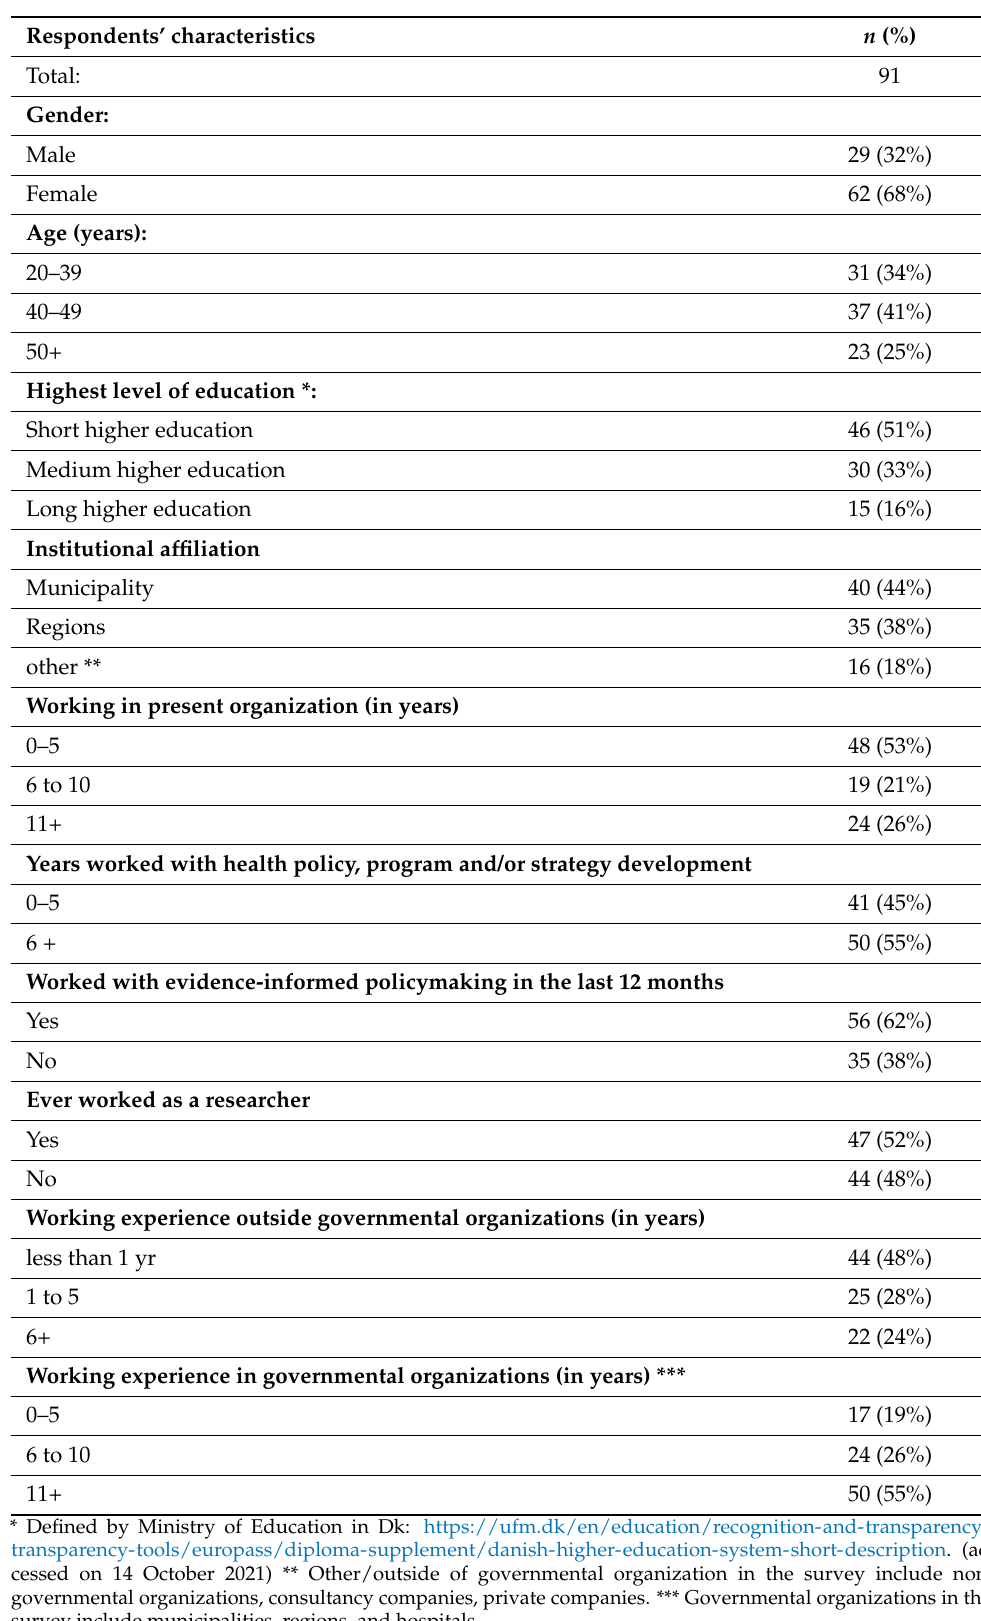
Table 1. Characteristics of study